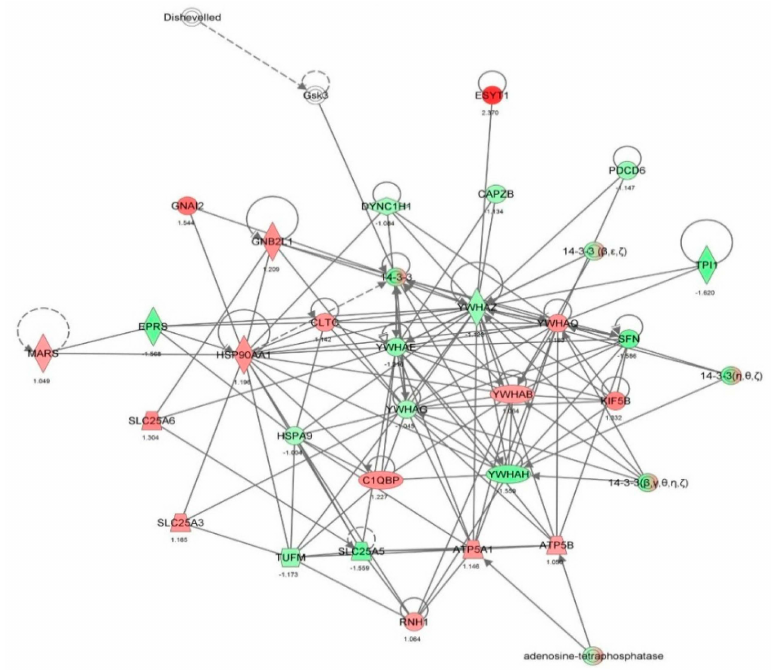
Figure 4. Vancomycin regulated protein trafficking, cell death and survival, and nucleic acid metabolism. Red indicates an up-regulation; green indicates a down-regulation. The intensity of green and red colors indicates the degree of down- or up-regulation. Solid arrow indicates direct interaction and dashed arrow indicates indirect interaction.